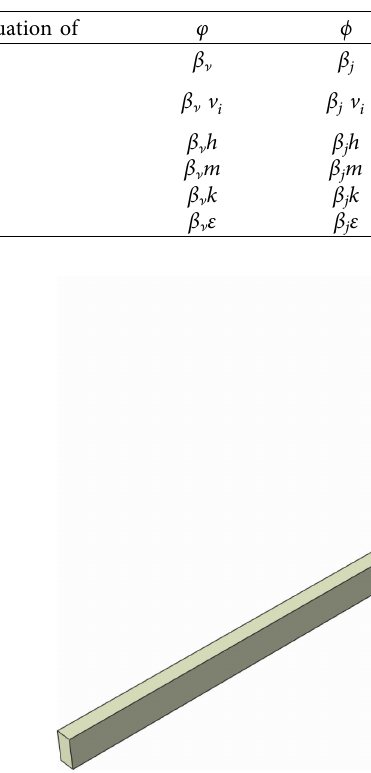
Table 1: Expressions for φ , ϕ , Γ , and S .